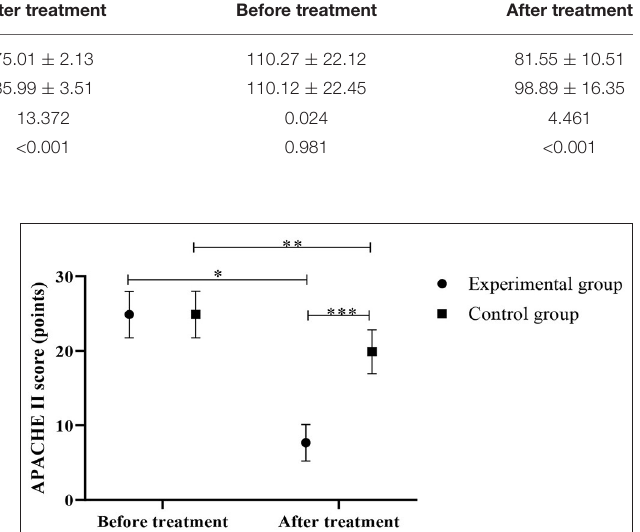
FIGURE 2 | Comparison of GCS scores between the control group and the experimental group (Mean, SD). The abscissa represents before and after the treatment, and the ordinate represents GCS score, points; the GCS scores of patients in the experimental group before and after the treatment were (6.59 ± 1.11) points and (13.27 ± 0.88) points respectively; the GCS scores of the control group before and after the treatment were (7.01 ± 1.12) points and (9.66 ± 0.53) points respectively; * Indicates that there is a significant difference in the GCS scores of the experimental group before and after the treatment ( t = 23.579, P < 0.001); ** Indicates that there is a significant difference in the GCS scores of the control group before and after the treatment ( t = 10.693, P < 0.001); *** Indicates that there is a significant difference in the GCS scores of the two groups of patients after the treatment ( t = 17.571, P < 0.001).